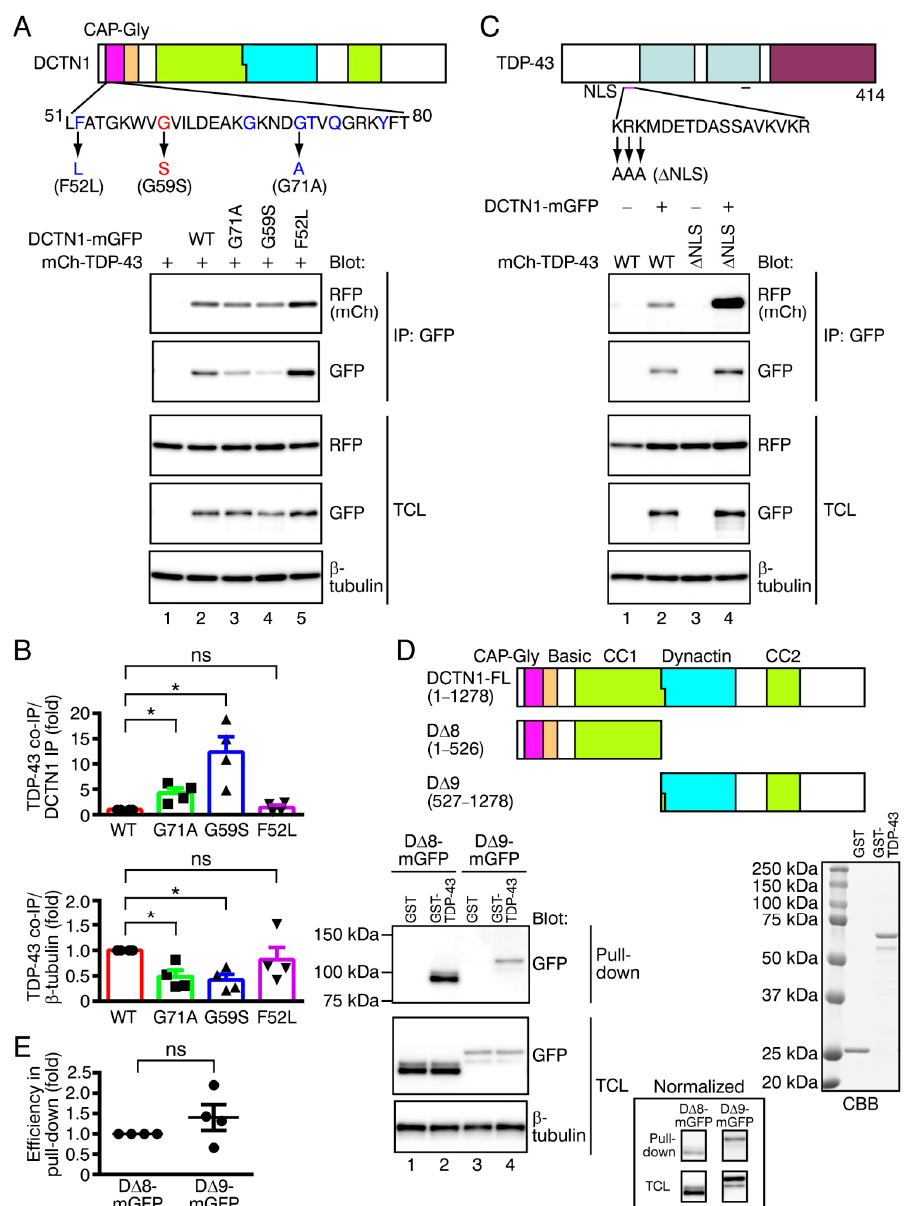
Figure 3. Effects of missense mutant DCTN1 and NLS-deficient mutant TDP-43 on the DCTN1-TDP-43 interactions, and in vitro DCTN1-TDP-43 binding. ( A ) Interactions of disease-linked missense mutants of DCTN1-mGFP, p.G71A (Perry disease), p.G59S (HMN7B), or p.F52L (Perry disease) with mCherry-tagged wild-type (WT) TDP-43 were examined by coimmunoprecipitation (co-IP) in COS-7 cells. ( B ) Quantification of interactions of DCTN1 missense mutants with WT TDP- 43, relative to WT DCTN1. The top panel shows the ratio of mCherry-TDP-43 to DCTN1-mGFP in the immunoprecipitates, and the bottom panel shows the ratio of the immunoprecipitated mCherry-TDP-43 normalized to levels of β -tubulin in the total cell lysates (TCL). Here and in subsequent figures, data are represented as the mean ± SEM. n = 4 (independent experiments). * p < 0.05 compared to WT by two-tailed paired t -test. ns: not significant. ( C ) Interactions between WT DCTN1-mGFP and TDP-43- ∆ NLS mutant. ( D ) A GST pull-down assay between DCTN1 fragments and GST-fused WT TDP-43. Cell lysates prepared from COS-7 cells expressing truncated mutant DCTN1 (D ∆ 8-mGFP or D ∆ 9-mGFP, top panel) were incubated with glutathione Sepharose beads preloaded with purified GST control or GST-TDP-43 (bottom right panel). The bound DCTN1 fragment was detected by Western blotting using anti-GFP (bottom left panel). The result was normalized according to the GFP signal intensity in TCLs, and is shown in the inset. ( E ) Quantification of DCTN1 truncated mutants pulled down with GST-TDP-43. The GST-pulled-down levels of D ∆ 9-mGFP were normalized to those of D ∆ 8-mGFP. n = 4 (independent experiments). p = 0.2949 (two-tailed paired t